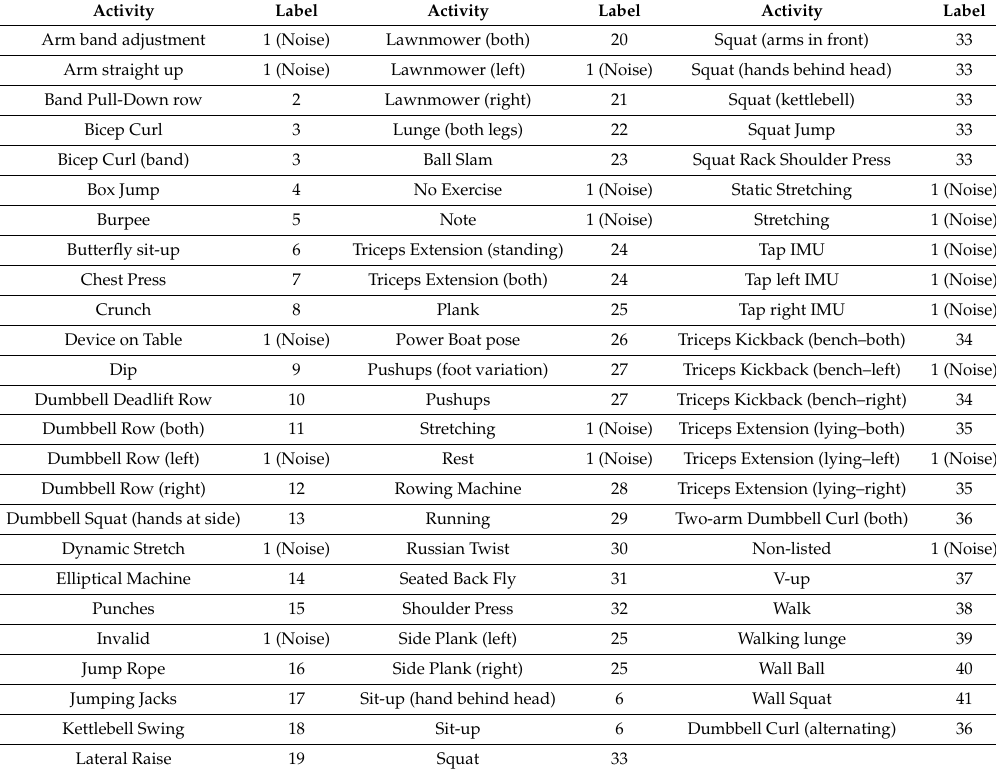
Table 2. Activity set in dataset